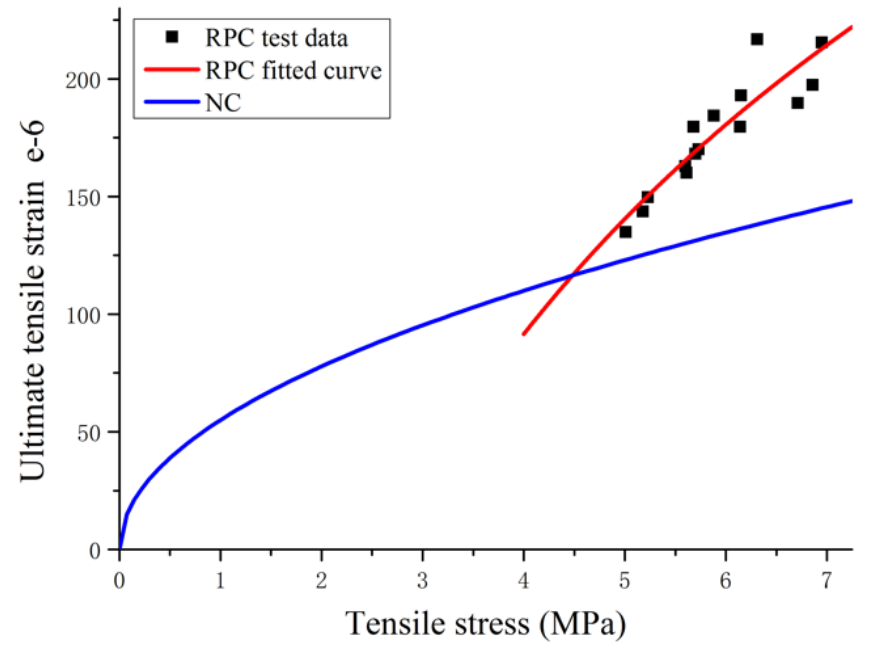
Figure 10. Relationship between tensile strength and ultimate tensile strain of